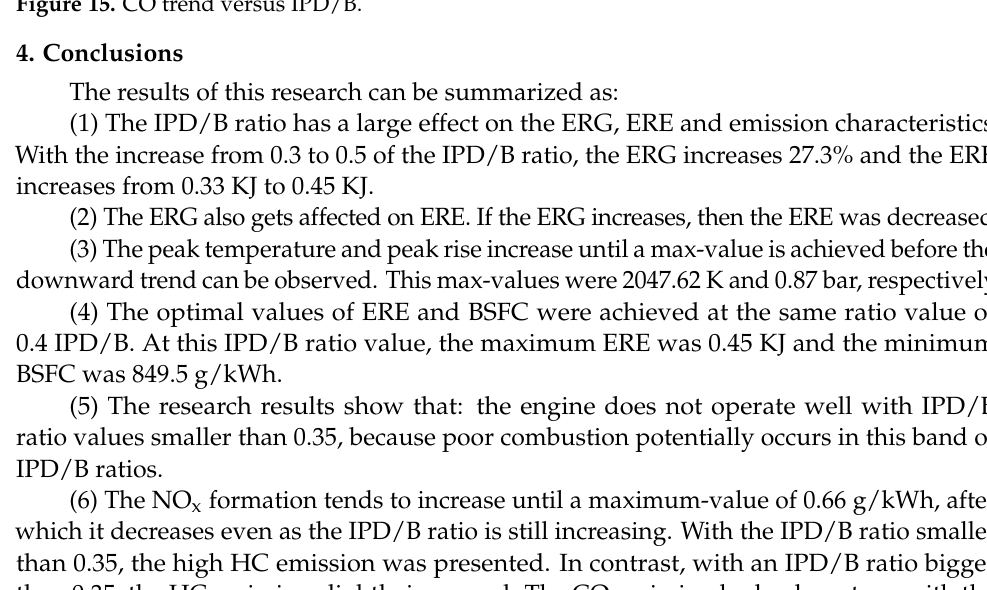
Figure 15. CO trend versus IPD/B.